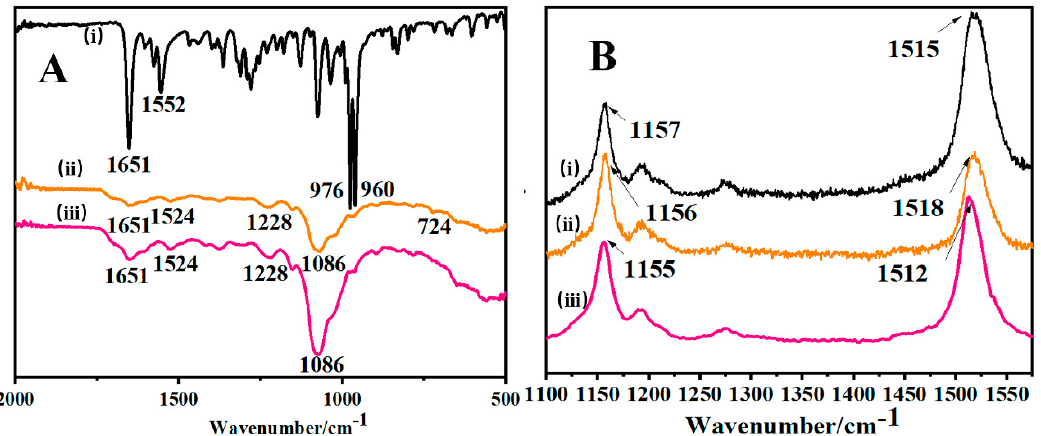
Figure 2. ( A ) Fourier transform infrared spectroscopy (FTIR) of AST (i), H-ADC (ii) or J-ADC (iii). ( B ) Raman spectroscopy analysis of AST (i), H-ADC (ii) or J-ADC (iii).